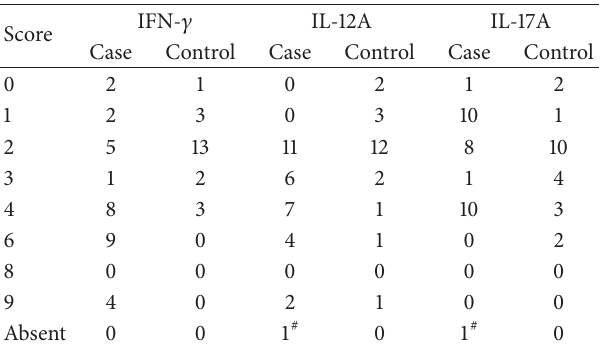
Table 5: Multiple bacteria could be detected in PDM patients. Bacteria 𝑁 (%) ( 𝑛 = 31 ) Mixture of different bacteria 12 (38.71) Pseudomonas